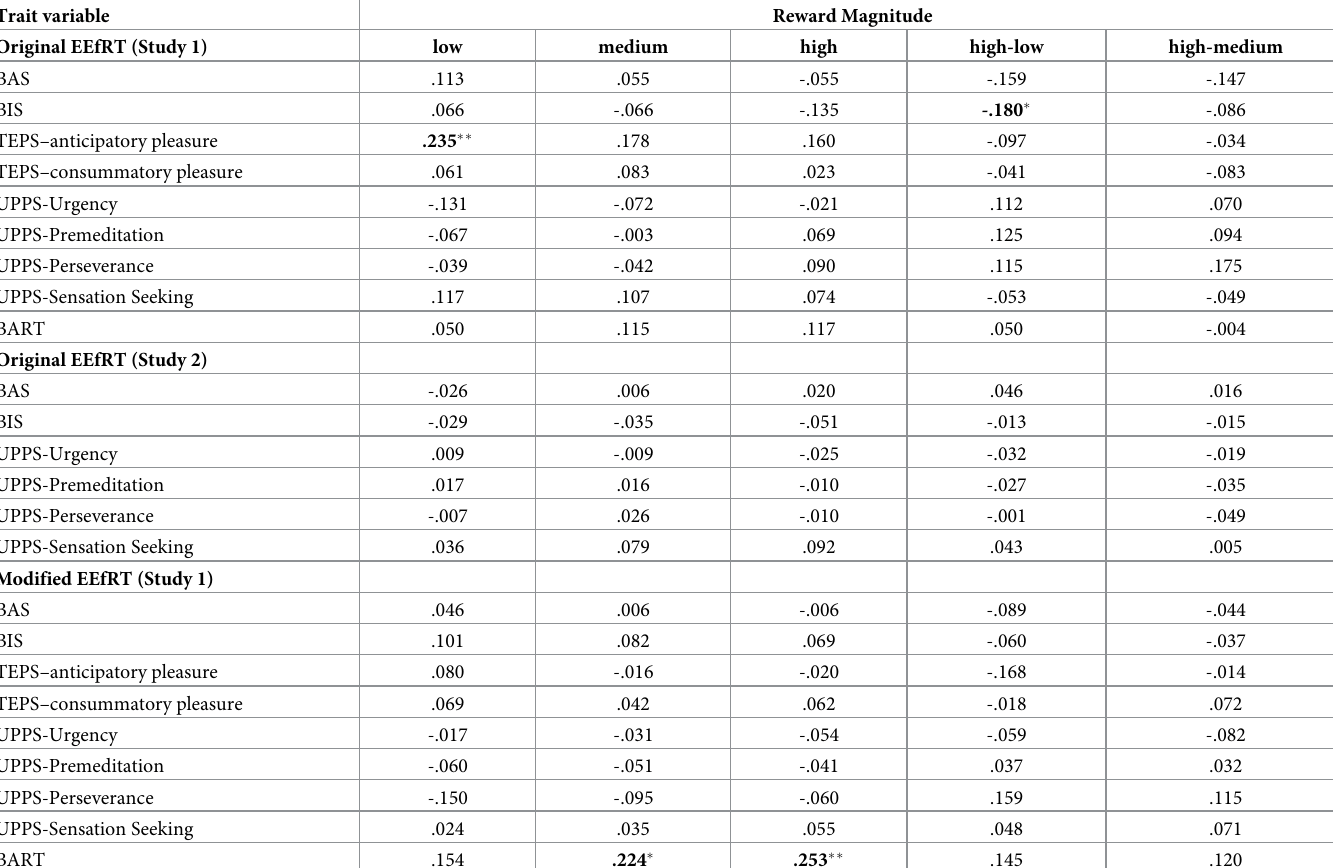
Table 4. Correlations between the original EEfRT (percentage of hard-task -choices), the modified EEfRT (mean number of clicks) and trait variables (Study 1 and 2). Trait